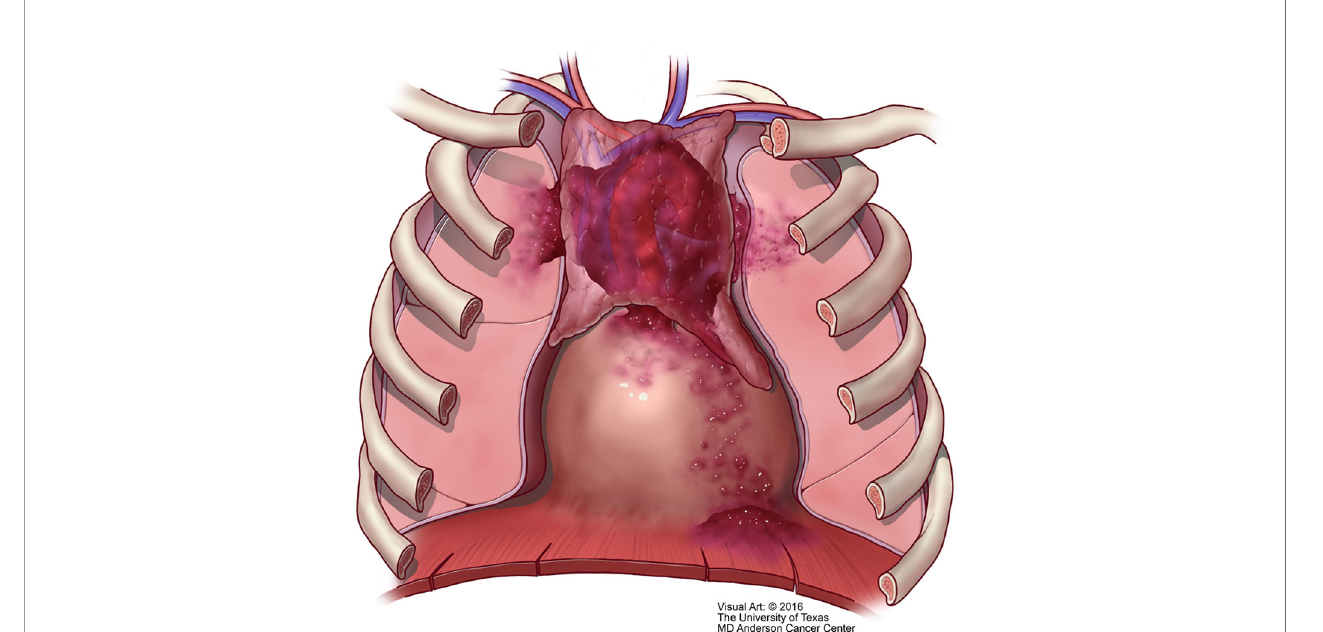
FIGURE 10 | T2 thymic carcinoma in which the tumor invades adjacent structures but within the mediastinal compartment.